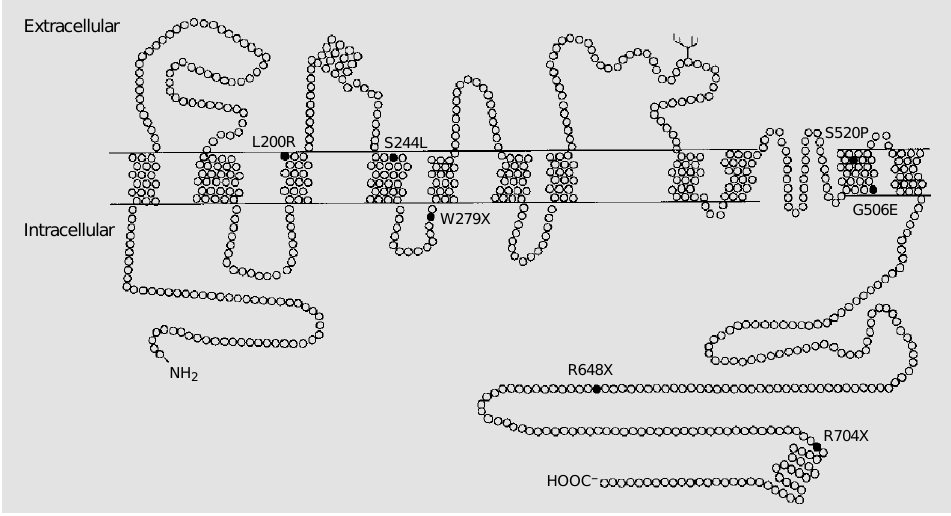
Figure 1 - Predicted two-dimen- sional structure of the ClC-5 chloride channel. Deduction of amino acids from ClC-5 cDNA predicts 13 transmembrane do- mains. Although there is a po- tential site for cAMP-dependent protein kinase, analogs of cAMP do not change the current of the ClC-5 channel (Refs. 40,41). Some common mutations in XLN patients are represented by black circles and the mutated amino acids are indicated (ob- tained from Ref.